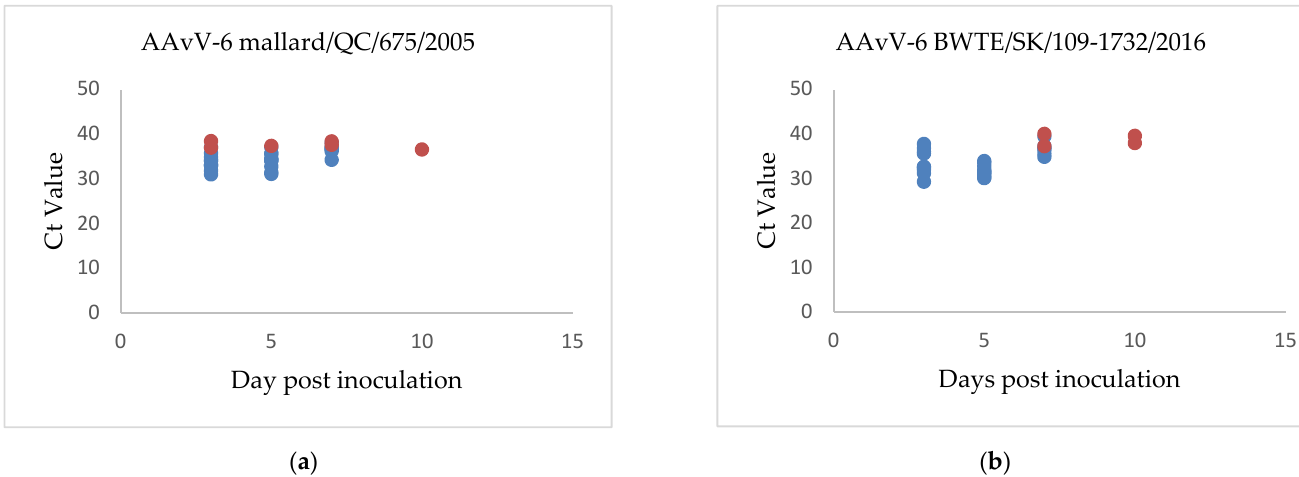
Figure 3. Shedding patterns of chickens inoculated with ( a ) AAvV-6 strain BWTE/SK/109-1732/2016 and ( b ) AAvV-6 strain mallard/QC/675/2005. Oral shedding Ct values are shown in blue, cloacal shedding Ct values are shown in red.